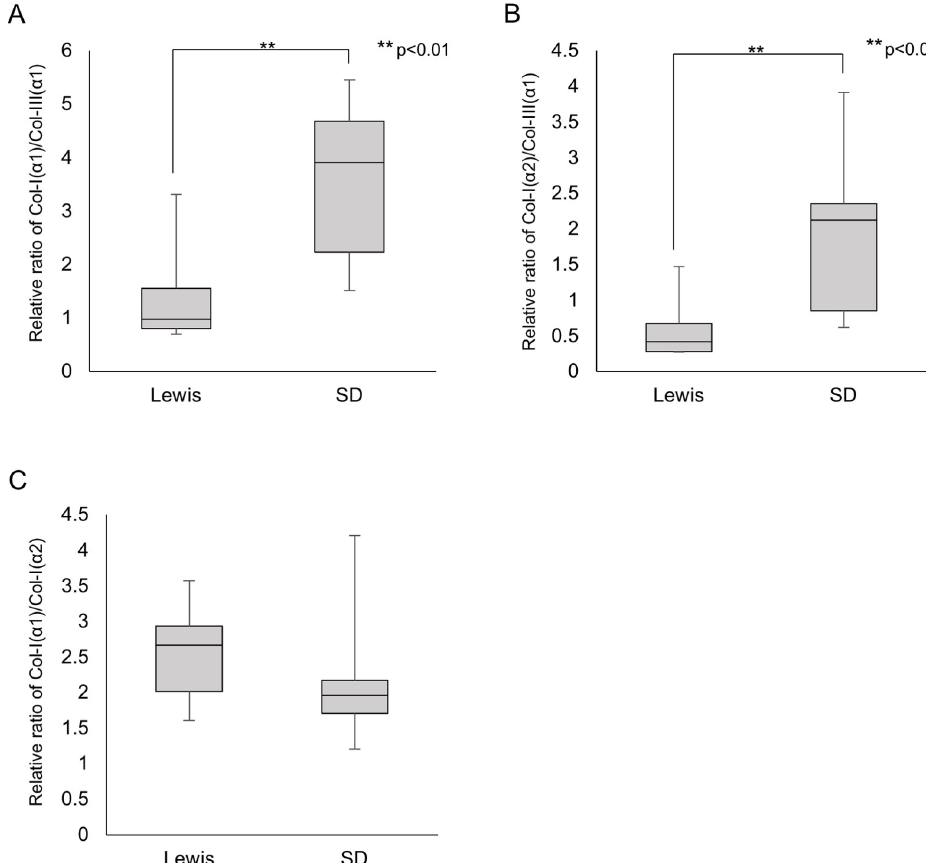
Fig 6. MS Analyses of pancreatic tissues in each rat strain. (A) Col-I( α 1)/Col-III( α 1) ratio. (B) Col-I( α 2)/Col-III( α 1) ratio. (C) Col-I( α 1)/Col-I( α 2) ratio.